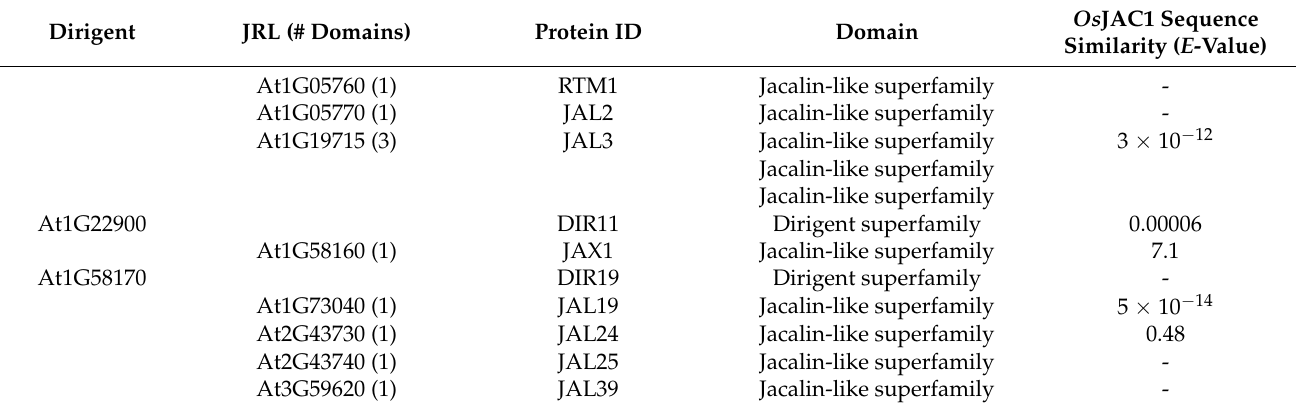
Arabidopsis DIR and JRL domains were identified via a NCBI Batch Web CD search. To determine sequence similarity, a TAIR protein BLAST was performed using Os JAC1 as the query. The table shows the E-values (smallest number of hits obtained at random in the search for similar sequences to Os JAC1 in the TAIR database). Gene identification numbers (Gene ID) of respective Arabidopsis DIR and JRL candidate genes are given. Protein names are given as well and the numbers in brackets indicate the number of JLR domains per protein.